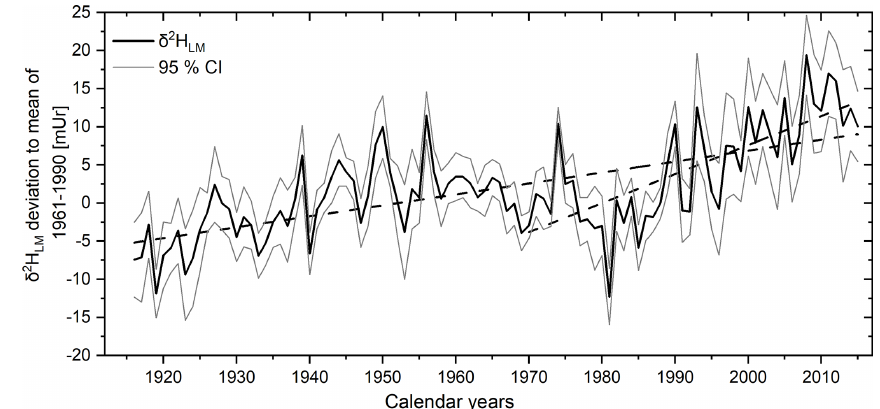
Figure 8. The corrected mean δ 2 H LM anomalies as deviations from the 1961–1990 mean from 1916–2015. The 100-year record (black line) represents the mean of the eight individual tree-ring series with 95% CI (grey lines). Linear regression lines (dashed) are shown for the whole period and from 1970–2015.